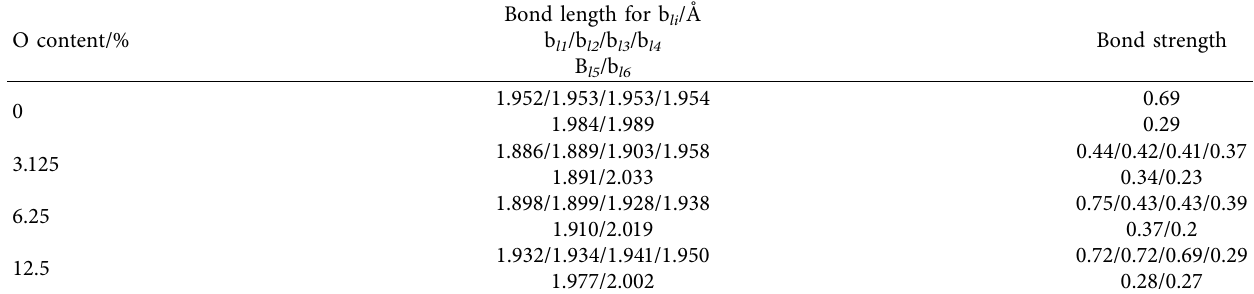
Figure 8: The TiO 6 polyhedron within the geometric structure of anatase TiO 2 in which the red sphere represents oxygen and the gray sphere represents titanium (a), basis vector direction, (b) and schematic geometry and bond marks of the polyhedron (c). Table 4: Bond length for b li and bond strength of Ti-O for intrinsic anatase TiO 2 and oxygen-defected anatase TiO 2 .